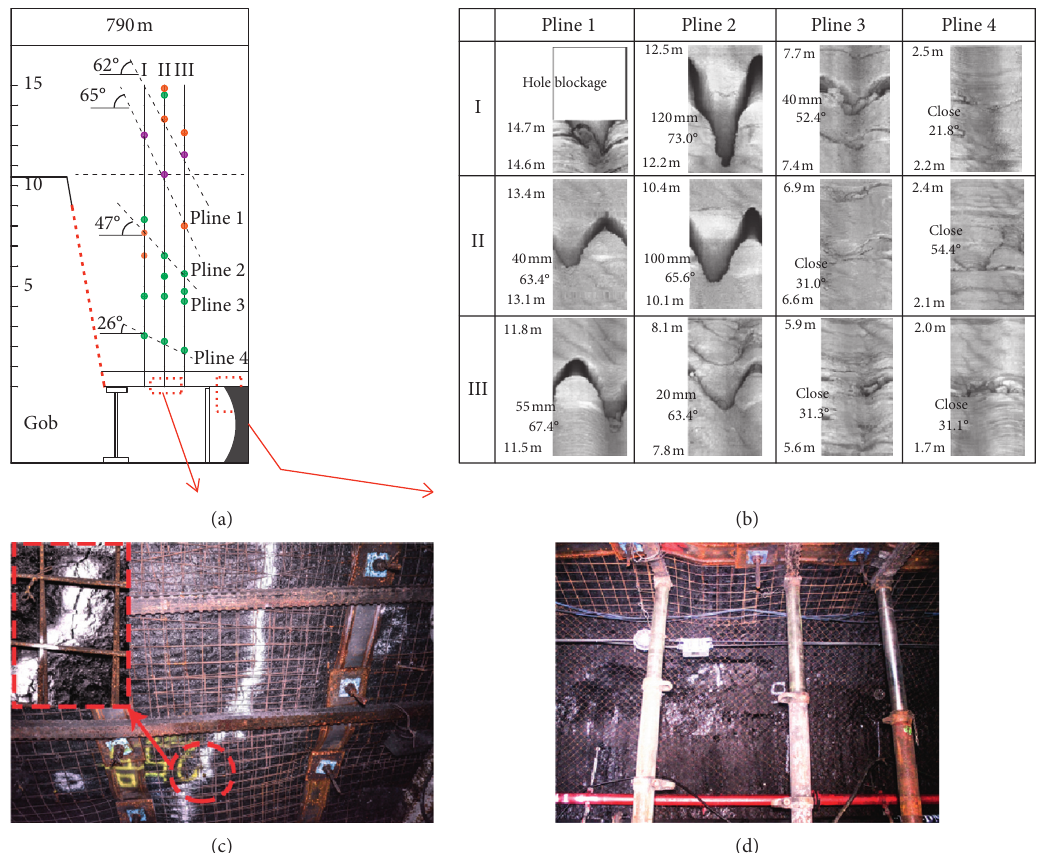
Figure 13: Borehole televiewer images and damage of surrounding rock: (a) the section with 790m offset from the open-off cut; (b) the borehole spreading pictures; (c) the cracks in the middle of the roadway roof; (d) the rib spalling in the curved coal